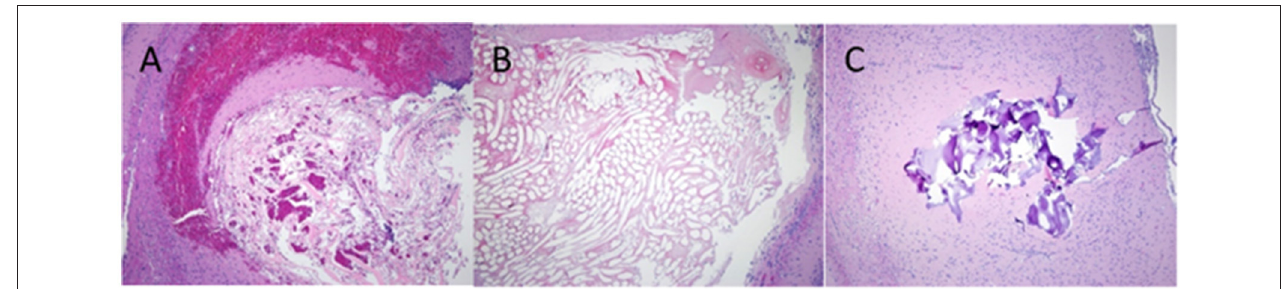
FIGURE 5 | H&E staining of rat brain following cortical injury treated with, (A) Chitin, (B) Surgicel and (C) FloSeal.